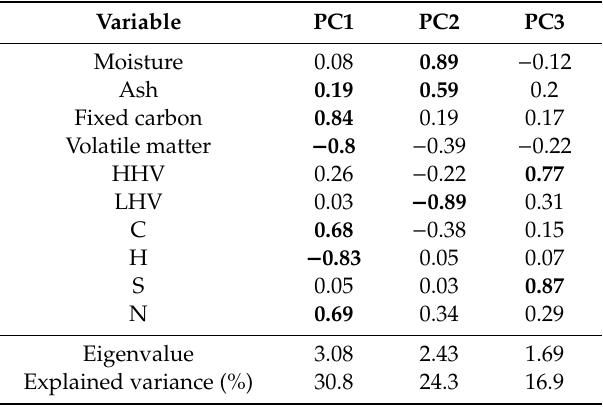
Figure 11. PCA biplot for tested willow biomass features. (To improve the readability of the chart, only the clone numbers are given without the note “UWM”. The names of the varieties are given in full. “B” means Bałdy location, while "O" means Obory location). Table 3. Factor loads of principal component